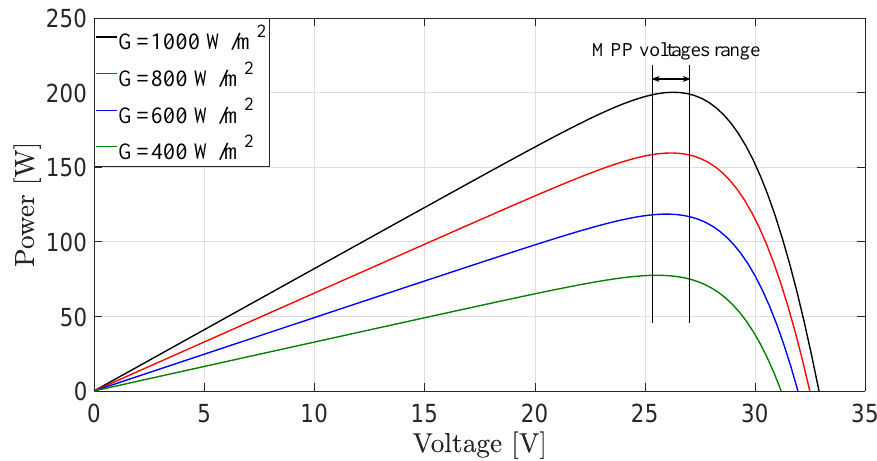
Figure 9. MPP voltages’ variation range with different radiation conditions.